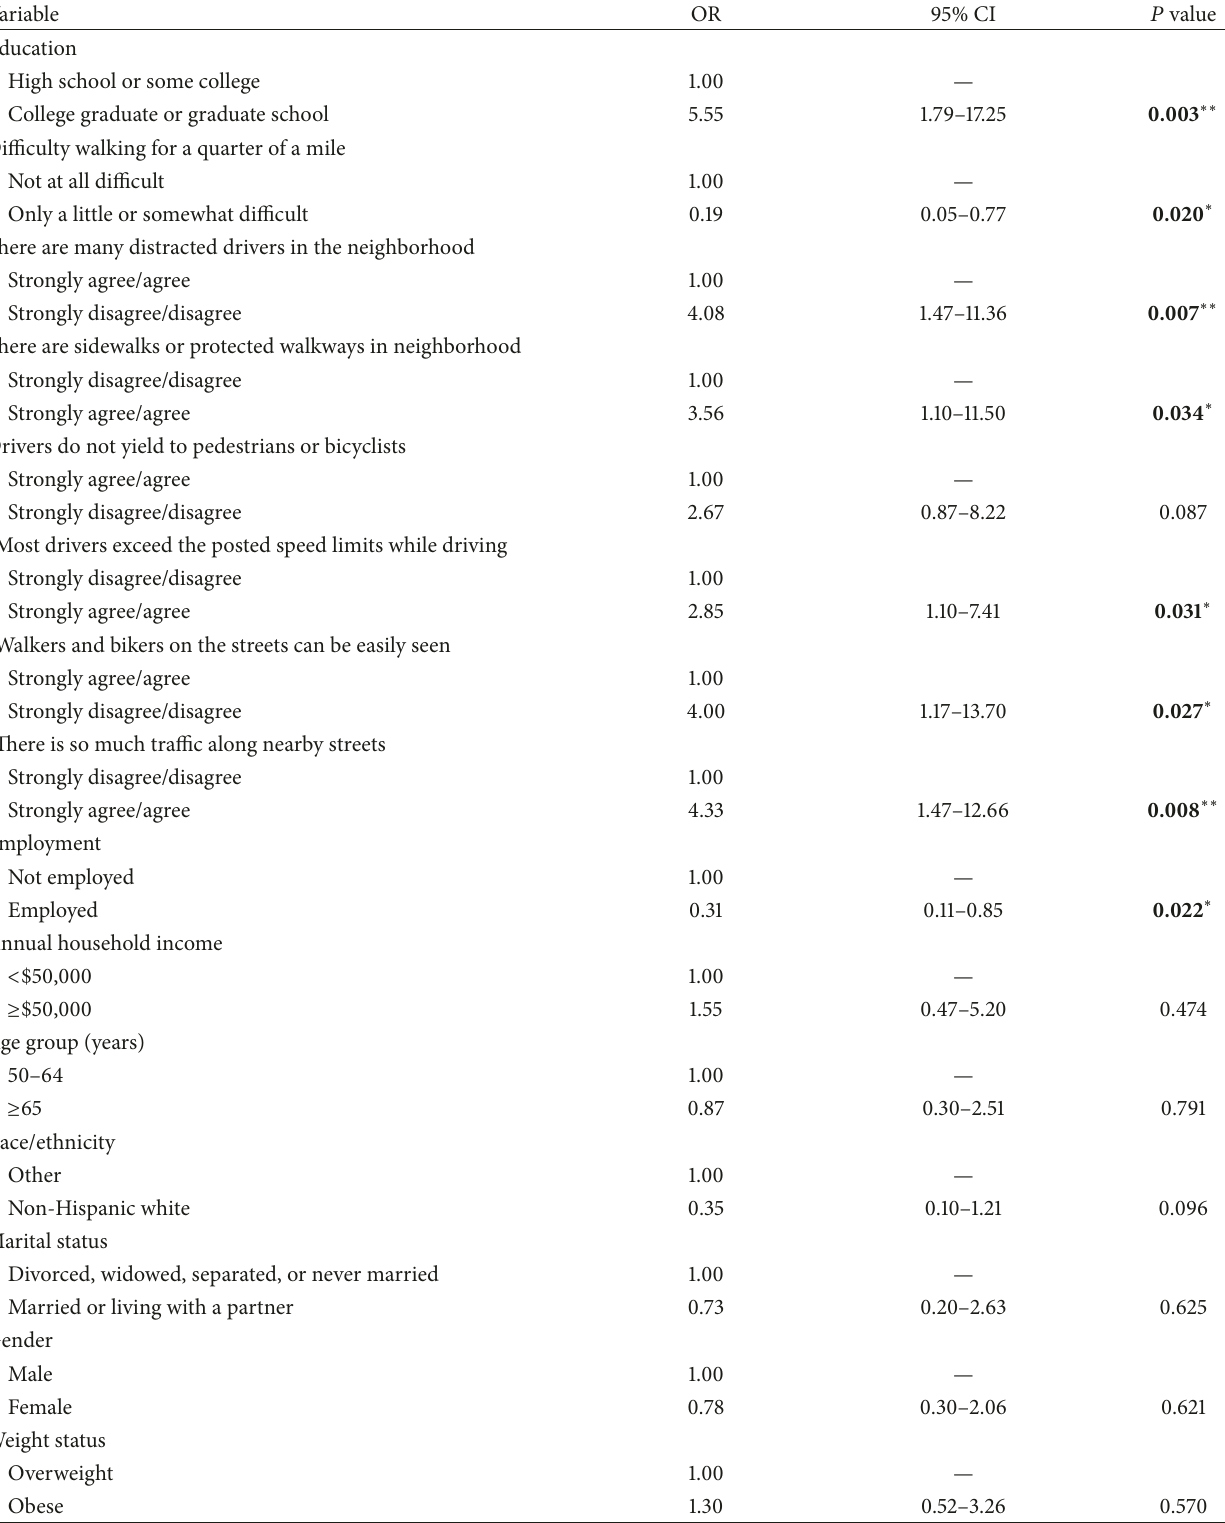
Table 3: Adjusted ORs and 95% CI of walking the recommended ≥ 150 minutes per week for any